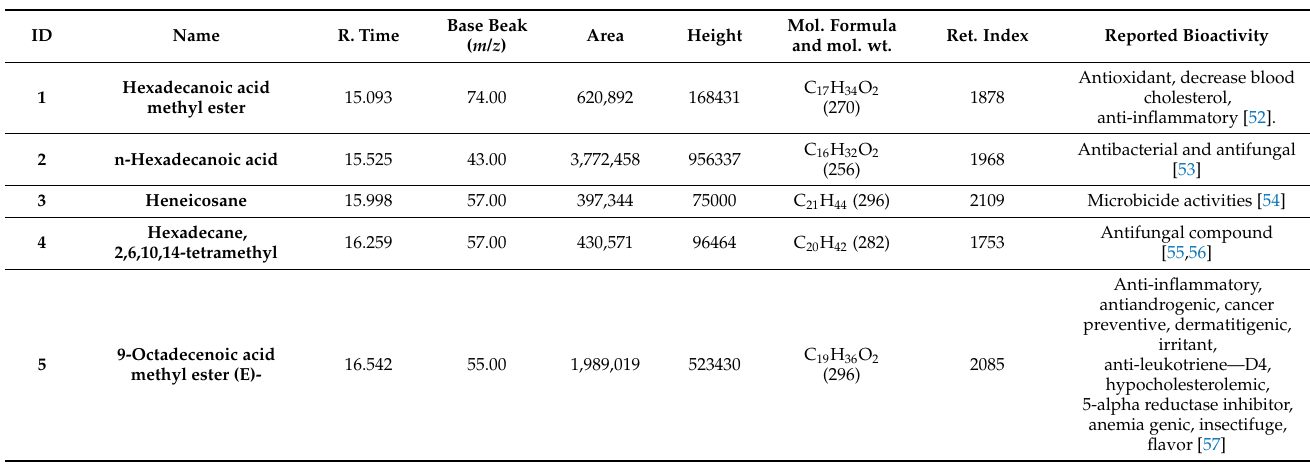
Figure 2. GC-MS chromatogram of kefir extract. Table 2. Identified compounds in the kefir extracts using GC-MS